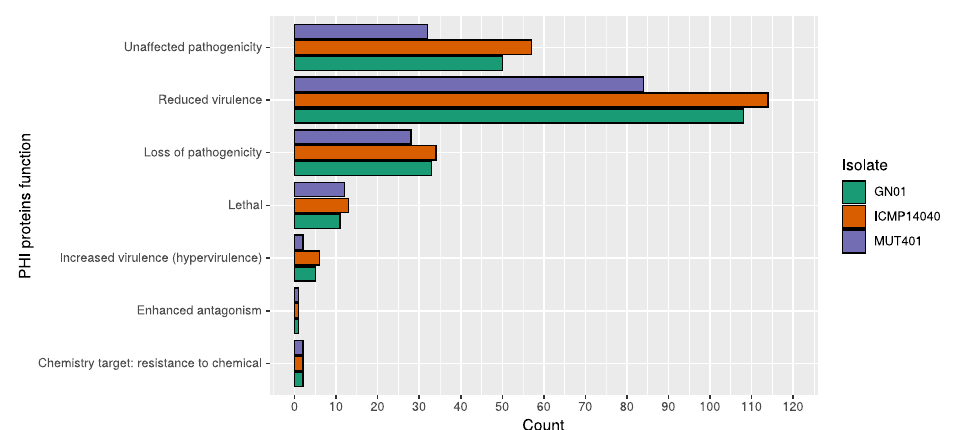
Figure 6. Putative pathogenicity-related features identified by BLASTp alignment towards the PHI